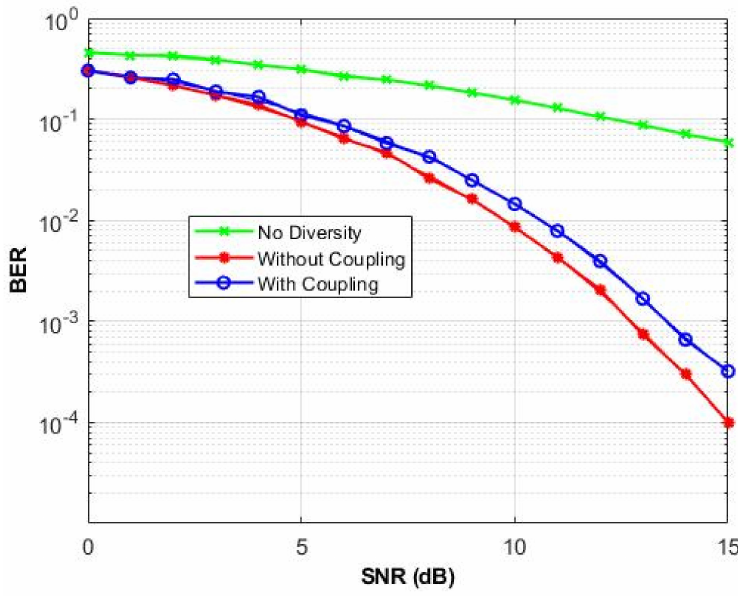
Figure 20. The BER vs. SNR curve.